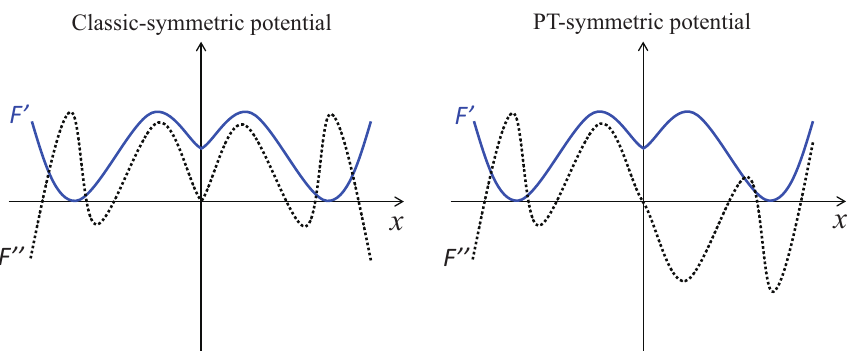
Figure 1. Spatial distribution for a typical scattering potential function having classic symmetry ( left ) and PT symmetry ( right ) along a single Cartesian axis, i.e., x -axis. F (cid:48) and F (cid:48)(cid:48) denote the real and imaginary parts of the potential function,